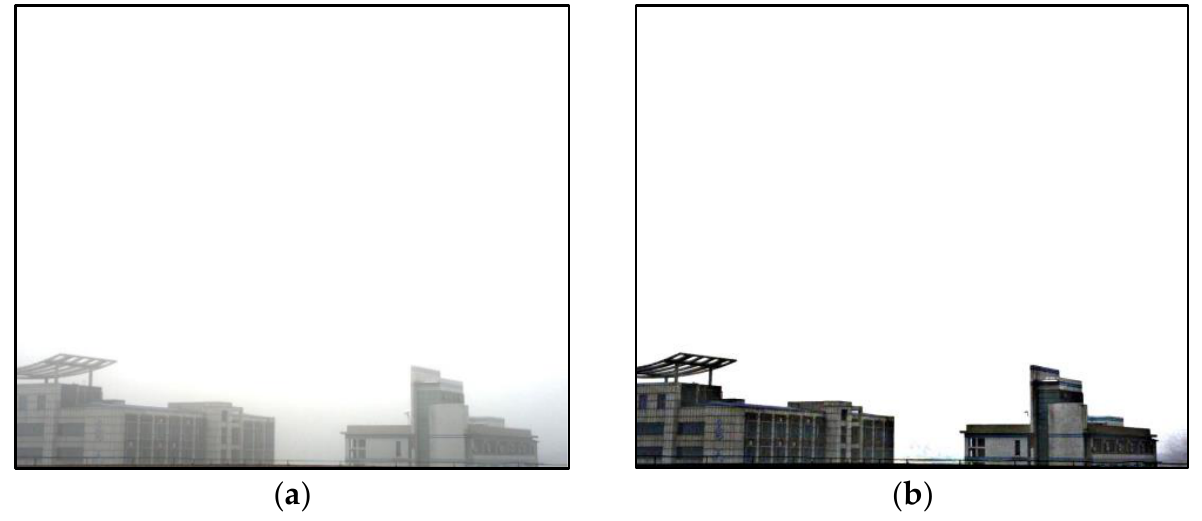
Figure 5. The comparison between original hazy image and dehazed image, ( a ) original hazy image,